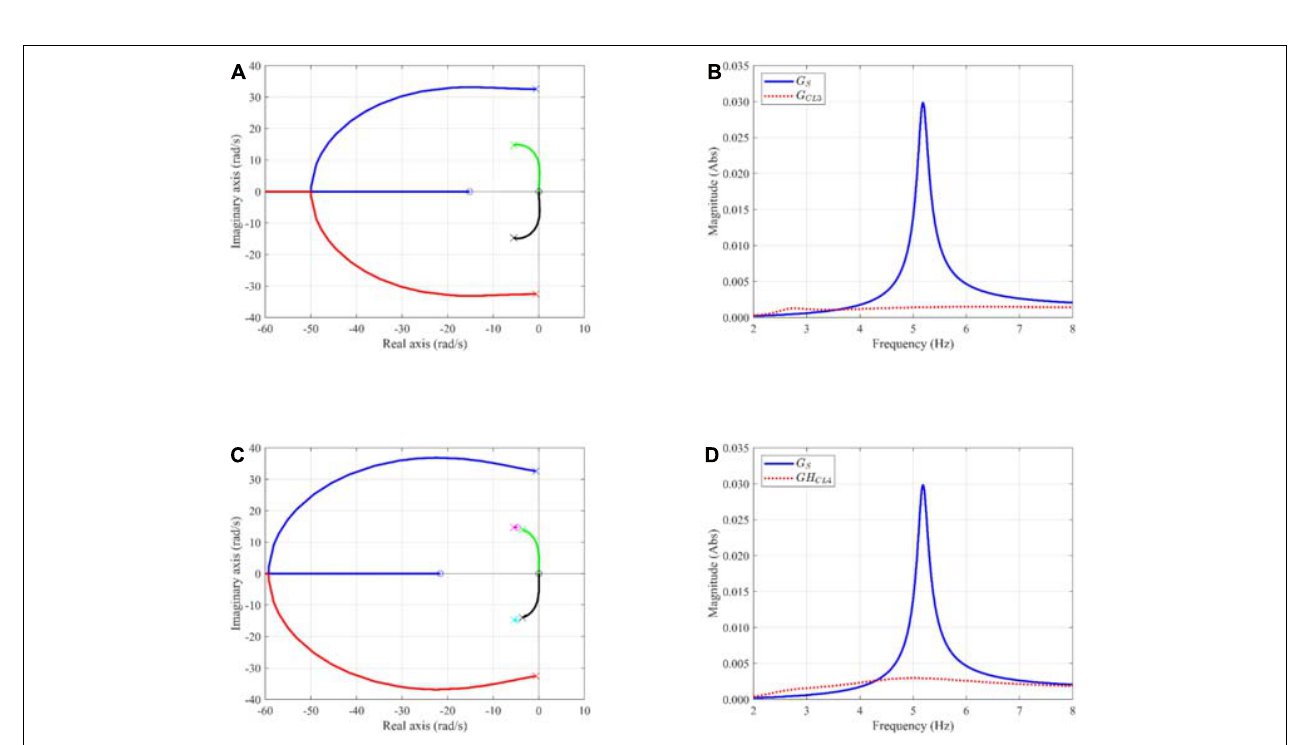
FIGURE 10 | AVA with ASI: (A) Root locus of a real actuator without HSI, (B) TFs of a real actuator without HSI, (C) Root locus of a real actuator with HSI, and (D) TFs of a real actuator with HSI. Symbols: ( × ) pole, (o) zero.